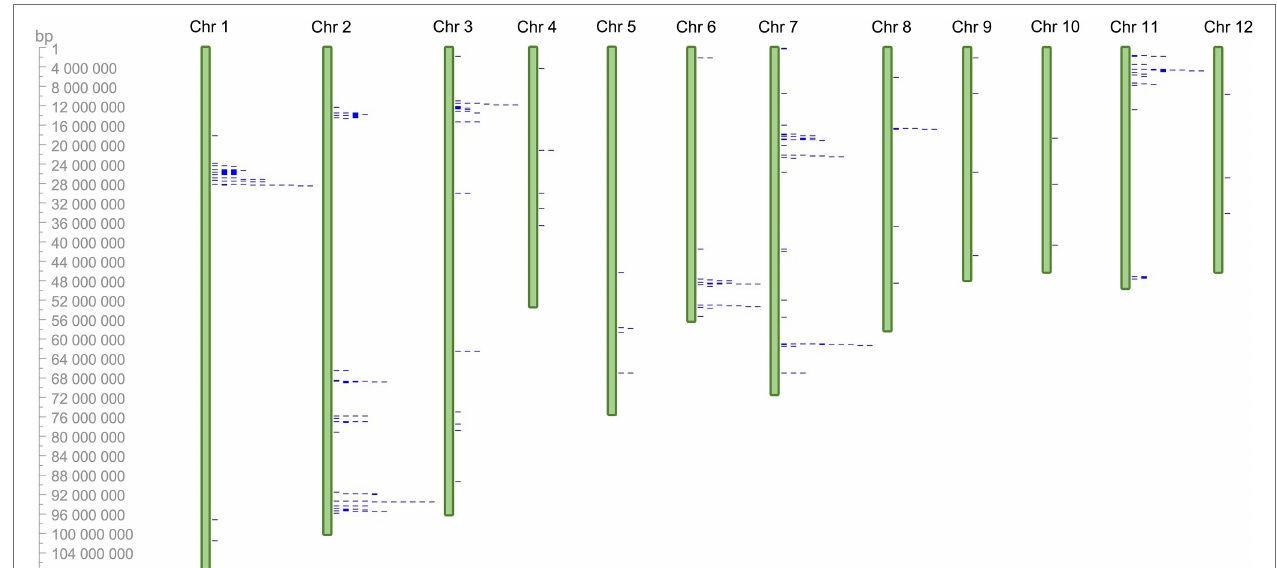
FIGURE 2 | Chromosomal location of 148 putative PaNLR genes identified within the Persea americana West-Indian pure accession genome (represented by blue marks). The genes were mapped to 12 chromosomes (green bars) using CViT. Chromosome 0 was excluded from the analysis as it is not representative of a true chromosome, thus 13 PaNLR genes could not be mapped to chromosomes 1–12 and are not shown in the figure.